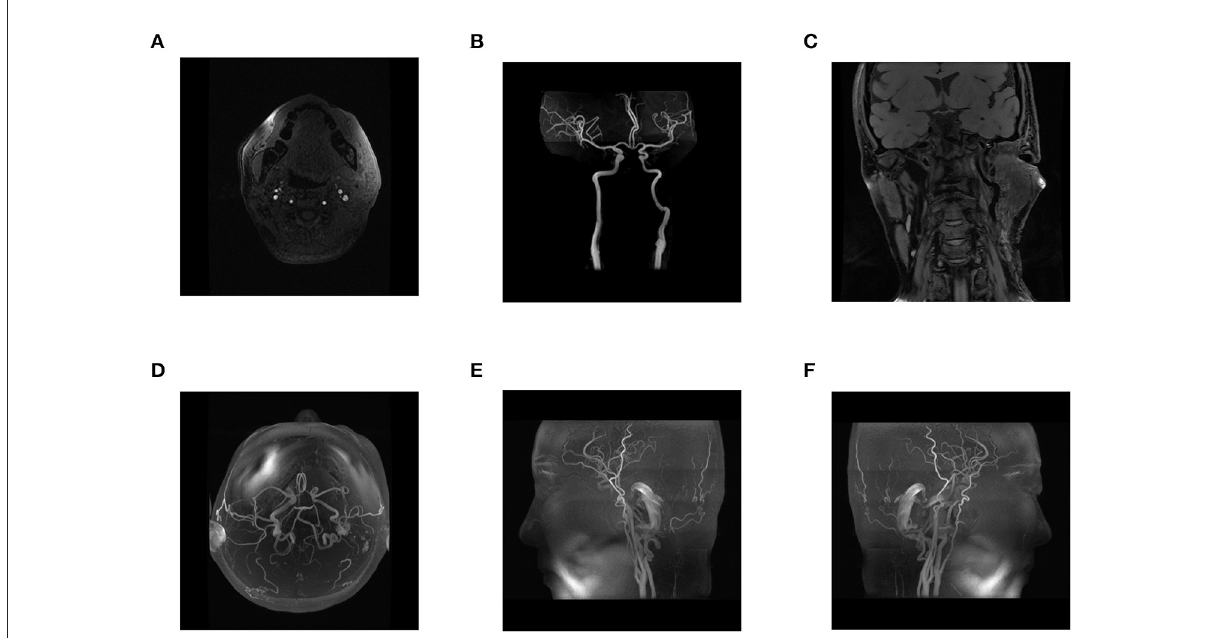
FIGURE4 (A–F) Postoperative head and neck MRA, three-dimensional reconstruction of head and neck MRA, and blood flow assessment. After surgery, head and neck MRA showed recanalization of the left internal carotid